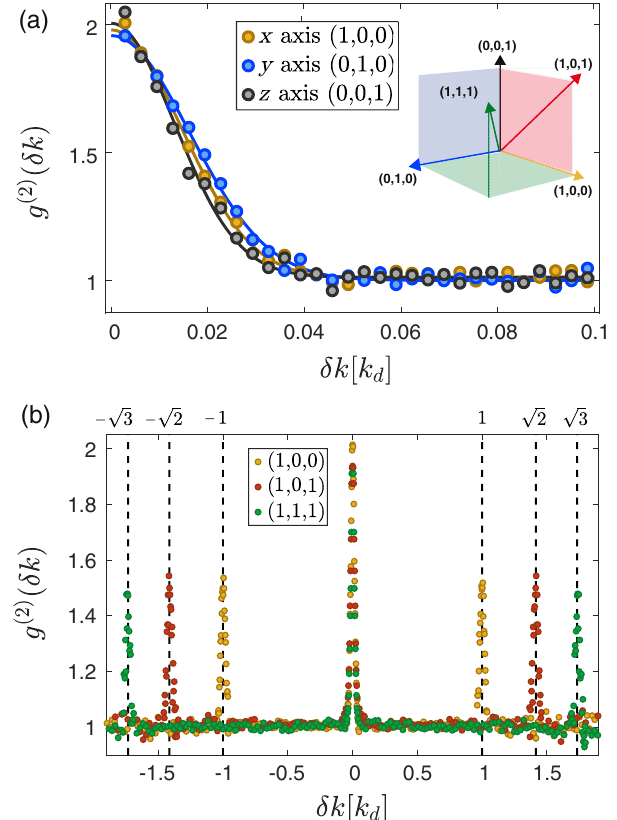
FIG. 2. Two-body momentum correlations in bosonic Mott insulators at U=J ¼ 100 with N ¼ 15 000 . (a) Plot of 1D cuts through the two-particle momentum correlation g ð 2 Þ ð δ k Þ as a ⃗ ⃗ u k: ⃗ u along the axis defined by ⃗ u ¼ n function of δ k ¼ δ x x þ ⃗ u ⃗ u n ; n ; n n . The values of the integers ð n are indicated y y þ z z x y z Þ next to the symbols of the data. The elementary volume we use to code the positions of individual atoms has a longitudinal length Δ k ¼ 0 . 003 k d along the axis where correlations are plotted and jj . The 1D cuts are plotted a transverse length Δ k ⊥ ¼ 0 . 015 k d along the three axes of the cubic lattice, illustrating the spherical symmetry of the experimental configuration. (b) 1D cuts g ð 2 Þ ð δ k Þ ⃗ k Þ along different plotted on a broader scale through the g ð 2 Þ ð δ axes of the reciprocal ⃗ k Þ in a Mott insulator with U=J ¼ 100 along plot g ð 2 Þ ð δ